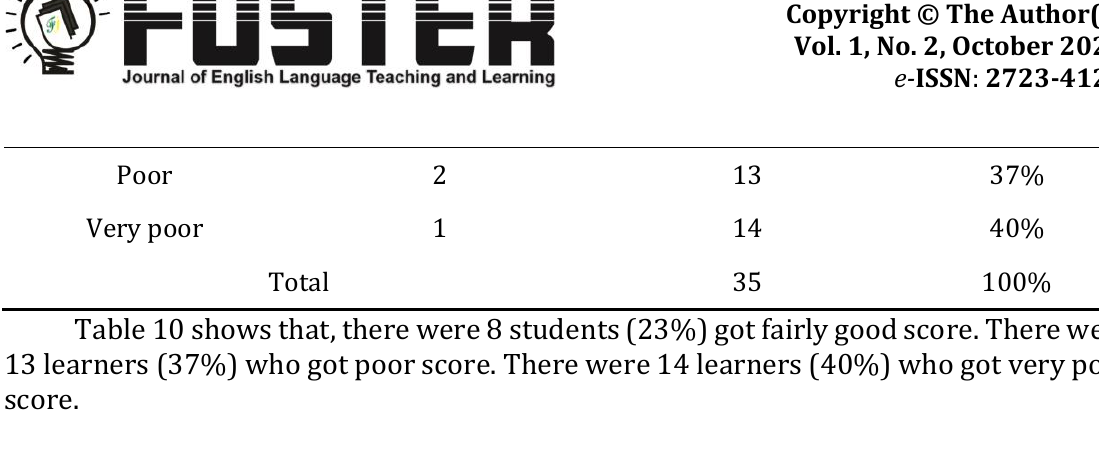
Table 11. Mean Point of Learners’ Comprehensibility Pre -survey result